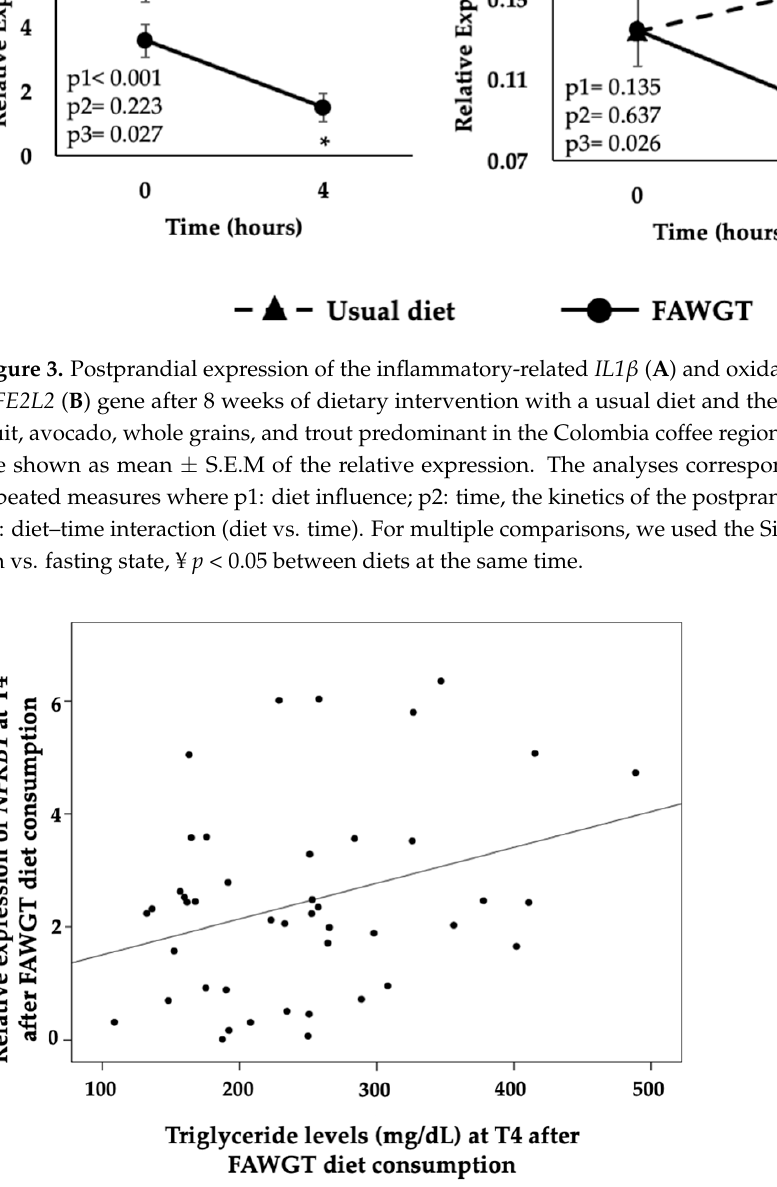
Figure 3. Postprandial expression of the inflammatory-related IL1 β (A) and oxidative-stress-related NFE2L2 (B) gene after 8 weeks of dietary intervention with a usual diet and the diet consisting of fruit, avocado, whole grains, and trout predominant in the Colombia coffee region (FAWGT). Val- ues are shown as mean ± S.E.M of the relative expression. The analyses correspond to ANOVA for repeated measures where p1: diet influence; p2: time, the kinetics of the postprandial response and p3: diet–time interaction (diet vs. time). For multiple comparisons, we used the Sidak test. * p < 0.05 4 h vs. fasting state, ¥ p < 0.05 between diets at the same time.